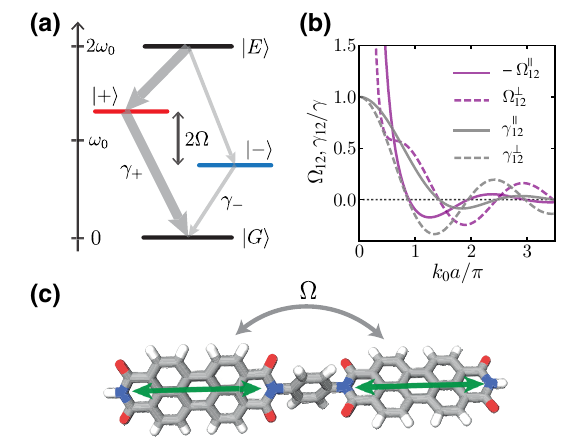
FIG. 2. (a) Decay and eigenstates in the collective two-emitter basis. Superradiant and subradiant decay channels emerge through the formation of symmetric and antisymmetric super- position states. (b) Dipole-dipole coupling (cid:9) 12 and collective decay rate γ 12 scaling with normalized interatomic distance k 0 a for parallel ( (cid:8) ) and perpendicular ( ⊥ ) orientation of dipoles (with respect to the connection vector R 12 ). (c) Possible experimen- tal realization of strong dipole-dipole couplings for two identical chromophores connected by an insulating bridge of length much smaller than λ 0 . The green arrows represent the orientation of the transition dipoles. Adapted from Ref.